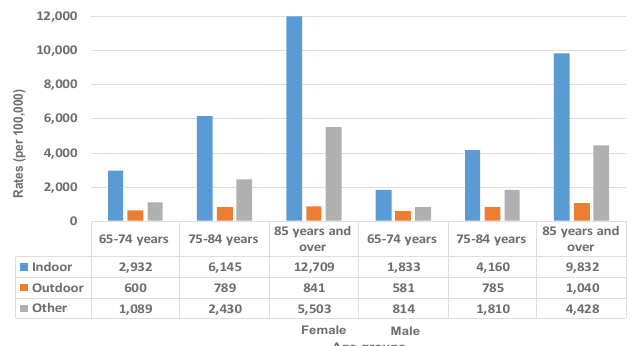
Figure 2. Indoor, outdoor, and other falls stratified by gender and age, NEDS* 2017. Rates of indoor, outdoor and “other” falls by gender and by age categories demonstrating a higher incidence of falls among women, advancing with age (for both gender). Note: We calculated the rate for each fall type by dividing the total number of falls in each age/gender category with the total number of population in that age/gender category. *NEDS, Nationwide Emergency Department